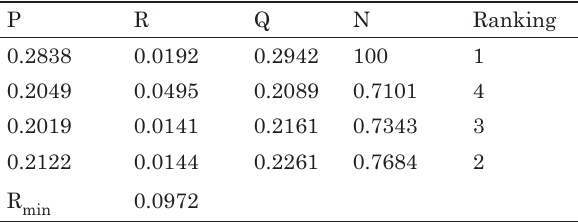
Table 10. Final results and ranking